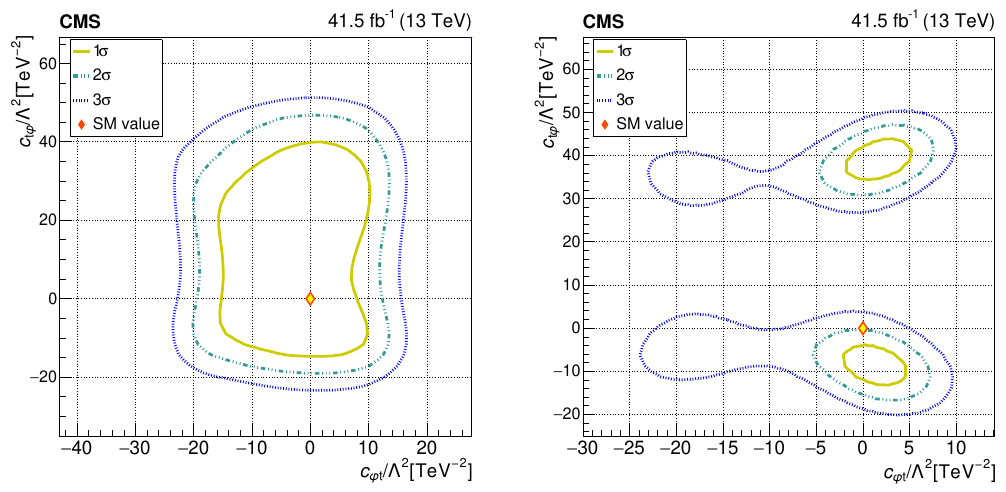
and c with the t ϕ ϕ t